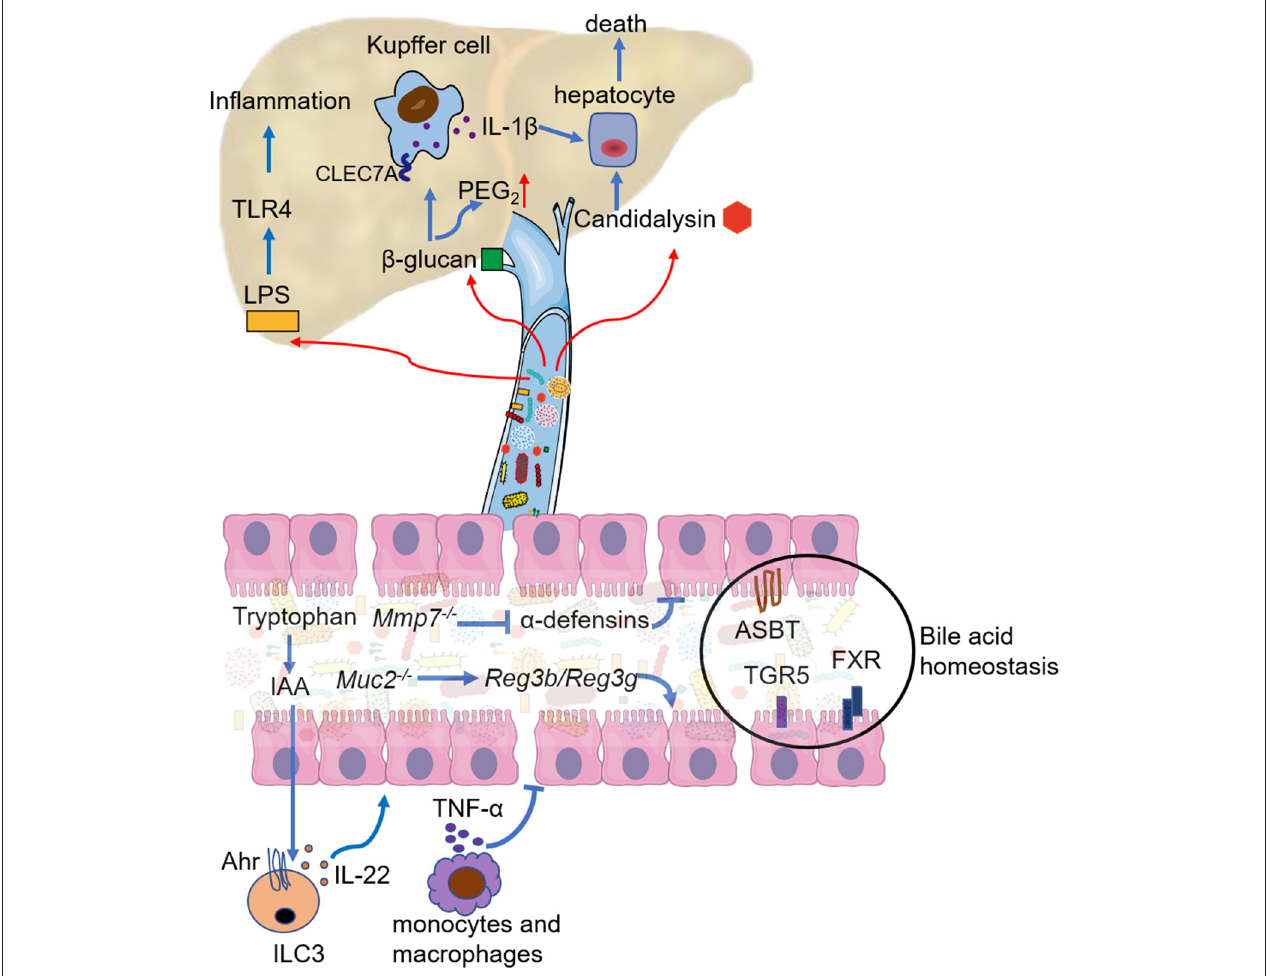
FIGURE 2 | Mechanistic contribution of the gut dysbiosis to ALD. Gut dysbiosis modulates the response of intestinal immune cells, mainly manifest as decreased IL-22 secretion by innate lymphoid cell 3 (ILC3) and increased TNF- α secretion by intestinal monocytes and macrophages. Both lead to the breakdown of the intestinal barrier function. Deficiency in active α -defensins of intestinal paneth cells (Mmp7 knockout) promotes pathogen associated molecular pattern (PAMP) translocation, but mucin2 deficiency enhances the expression and activity of Reg3b and Reg3g. Bile acid homeostasis is disturbed in ALD, and the regulation of apical sodium-dependent bile salt transporter (ASBT), bile acid receptor (TGR5), and farnesoid X receptor (FXR) could restore bile acid homeostasis and ethanol-associated dysbiosis. LPS from the intestine aggravates liver inflammation mainly through TLR4 signaling. 1,3- β -glucan from the overgrowth of fungi on the one hand binds to the C-type lectin domain family 7 member A (CLEC7A) of Kupffer cells and promotes liver inflammation, on the another hand increases PGE 2 production in the liver. Candidalysin from Candida albicans has directly cytotoxic to